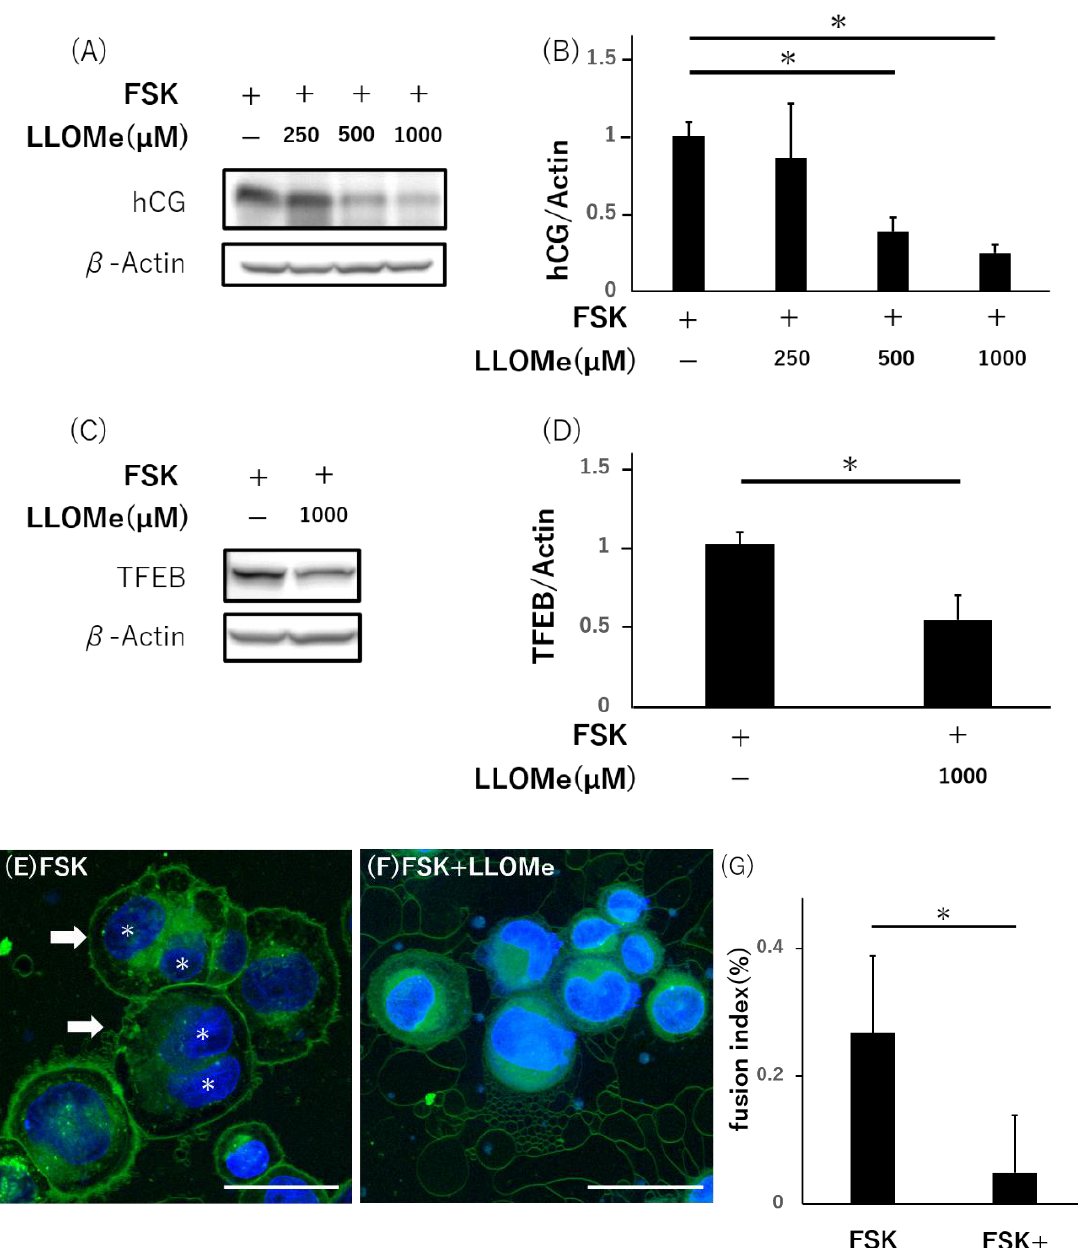
Figure 5. LLOMe induced the failure of syncytialization in BeWo cells. The hCG production was evaluated in BeWo cells with the indicated concentration of LLOMe in the presence of FSK ( A ). The graph shows the intracellular hCG levels in BeWo cells with LLOMe and FSK ( B ). Protein expression of TFEB was evaluated as a central regulator of autophagy ( C ). The graph shows the quantified protein levels of TFEB ( D ). BeWo cells were treated with FSK 25 μ M for 72 h to promote fusion ( E ), and simultaneously treated with LLOMe ( F ). The cell membrane was stained with Di-8-ANESS (green) and nuclei with DAPI (blue). The fused cells, which are indicated with arrows, included multiple nuclei indicated with asterisks. Scale bar: 50 μ m. The fusion index was shown in ( G ). Six randomly selected fields of view were captured and used for analysis. The graphs were obtained from the three independent results. A significance test was performed: * p < 0.05.